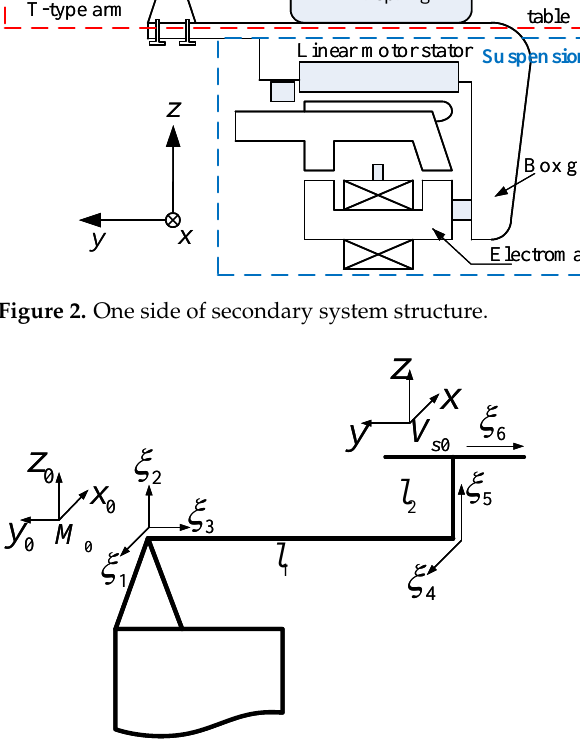
Figure 3. Definition of reference coordinates and screw